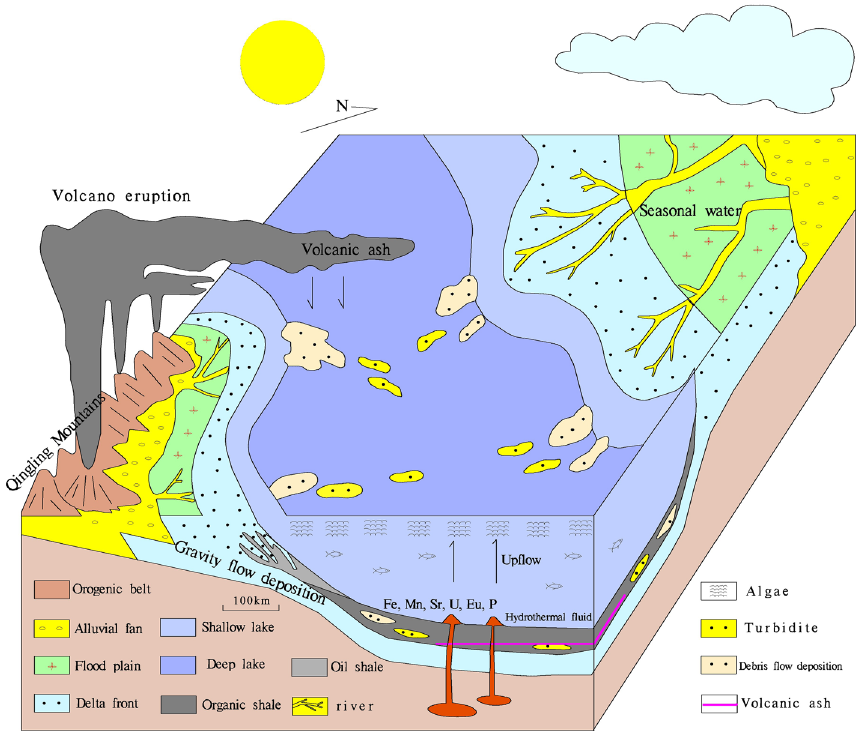
Figure 9. Sedimentary model map of the Late Triassic in the Ordos Basin(Map modified from reference 8 ,(The Figure is drawn with Mapgis6.7, version number is 6.7, the map from URL link: https:// www. tandf online. com/ doi/ full/ 10. 1080/ 08120 099. 2019. 16127